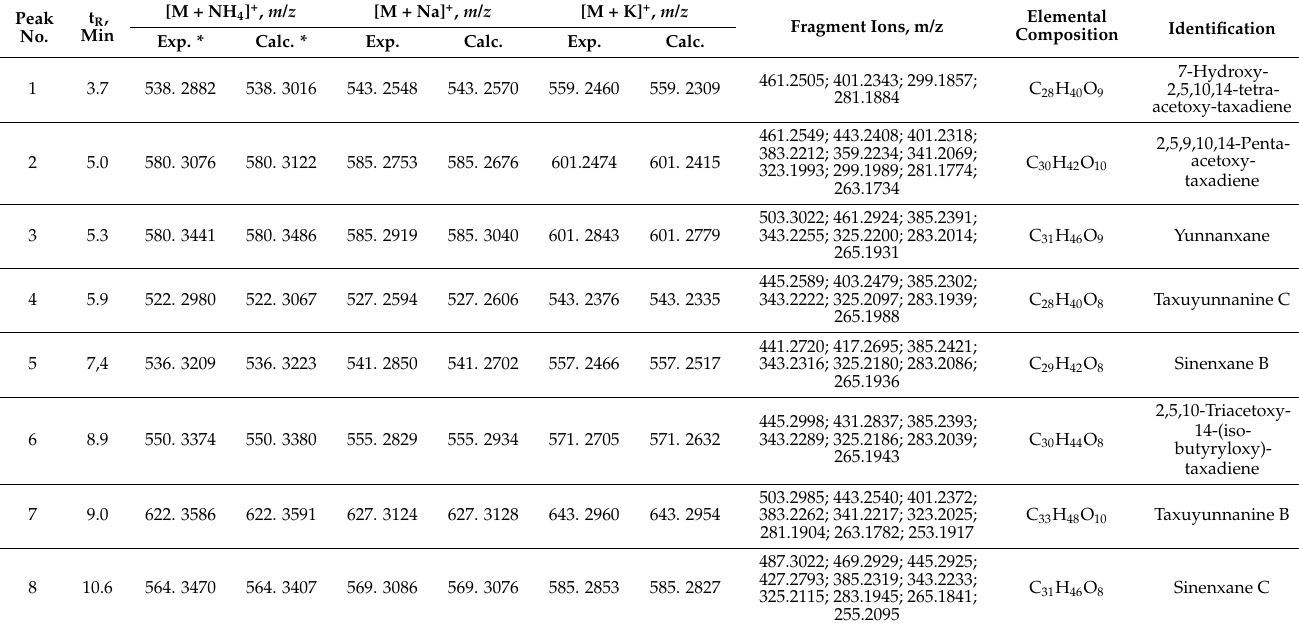
Table 4. Results of UPLC–ESI-MS analysis (positive ion mode) of an alcohol extract from the biomass of T. baccata cell suspension culture ( Tb-msu /B5-NB-ac line grown in a 20-L bioreactor). Peak numbers correspond to those in Figure